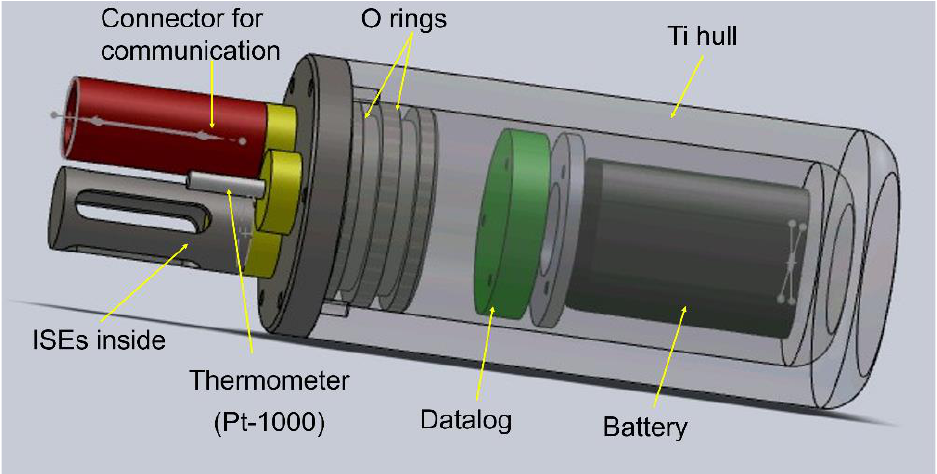
Figure 5. Assembly structure diagram of the MPCS.